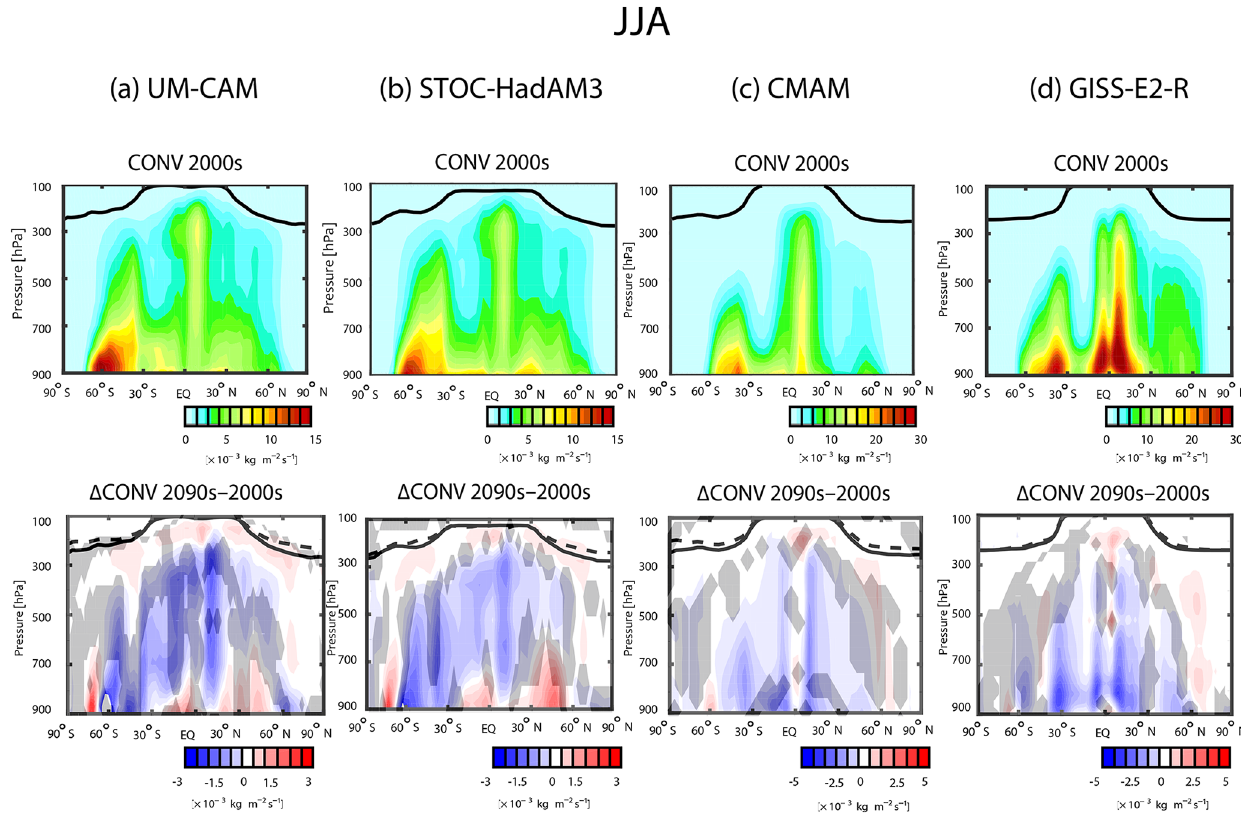
Figure 7. Same as Fig. 6 but for JJA. Note the different scales for (i) UM-CAM and STOC-HadAM3 and (ii) CMAM and